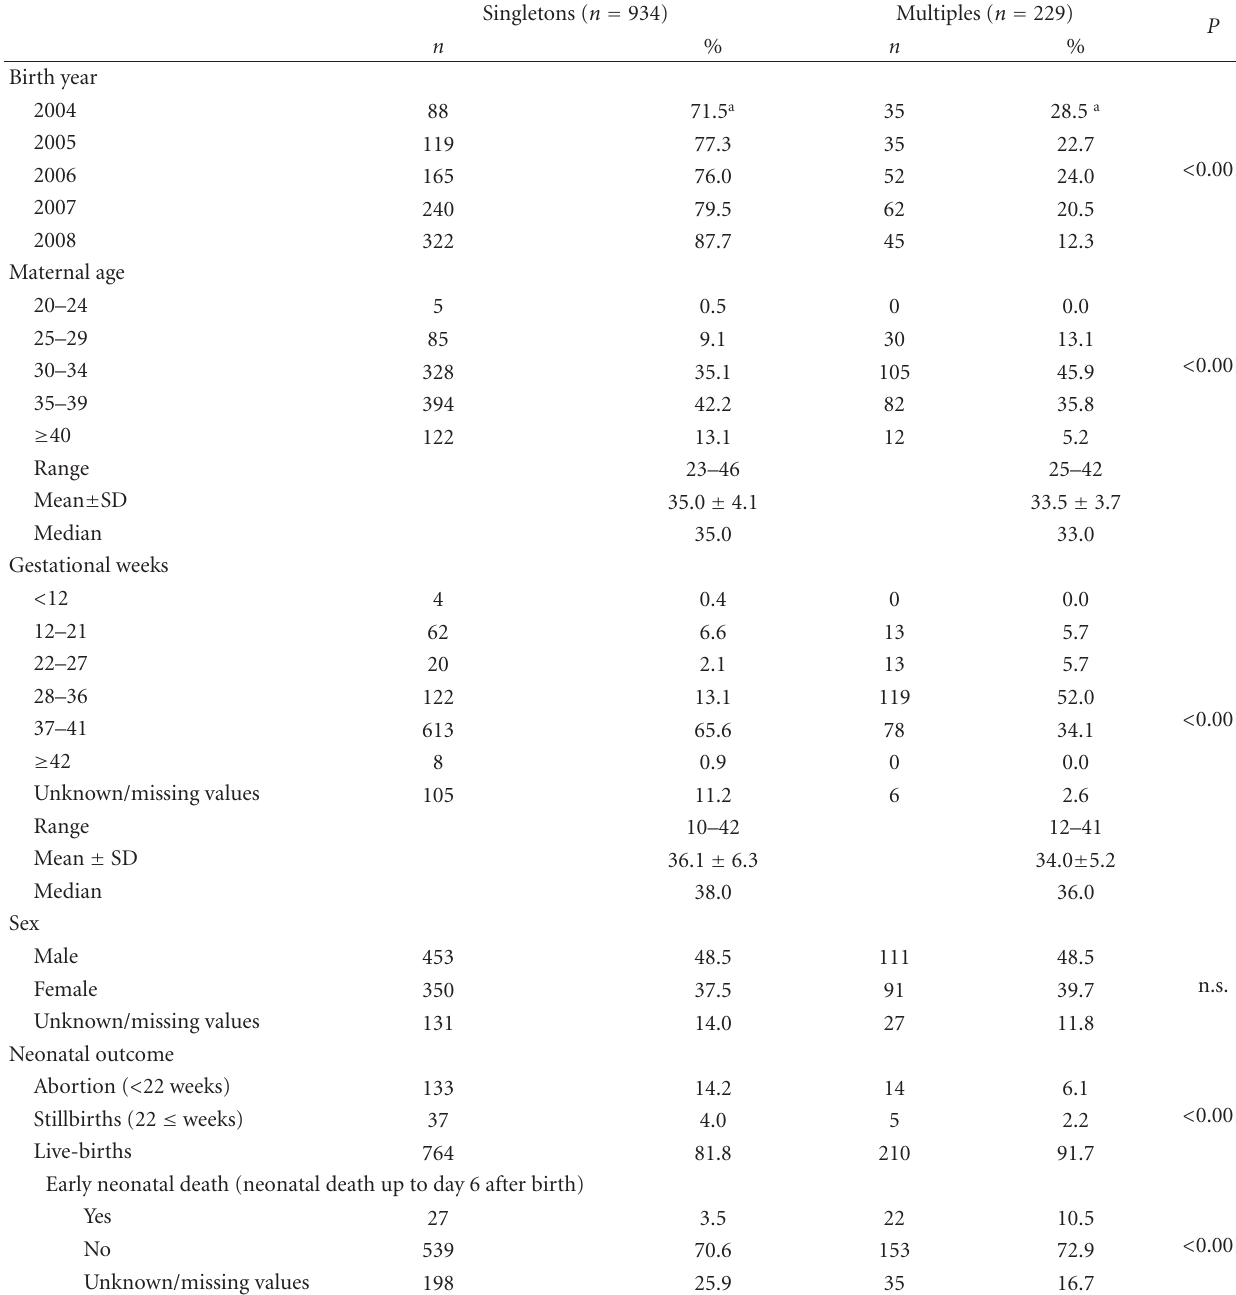
Table 1: Demographic and perinatal outcome data of the ART pregnancies with birth defects of known